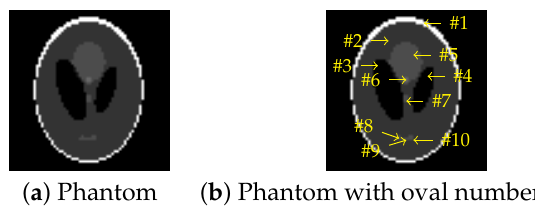
( b ) Phantom with oval number labels Figure 4. Base phantom. Table 1. Deformation ratios from base phantom. Symbol * indicates that the deformation ratio for the attribute uses a common value for each oval in the same group. See Figure 4b for “oval numbers”.